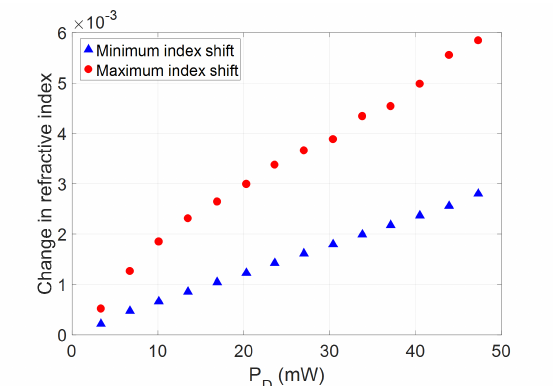
Figure 5. Variation in minimum and maximum thermally induced modal refractive index shifts of the device extracted from fitting of the transmission spectra.